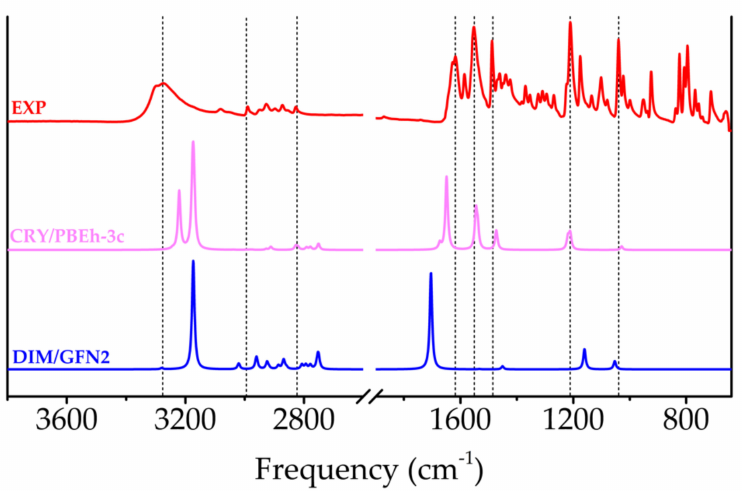
Figure 5. Experimental (red line) vs. computed melatonin IR spectra with anharmonic corrections. CRY/PBEh-3c corresponds to the calculated spectrum of the crystal structure at the PBEh-3c level (pink line), while DIM/GFN2 to the spectrum of the Indole–Indole dimer at the GFN2 level (blue